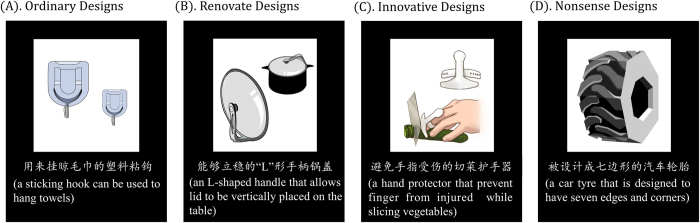
Examples of the four types of designs.Please note only the Chinese interpretations were presented in the formal fMRI experiment, the English translations of the Chinese interpretations are given here for illustration.